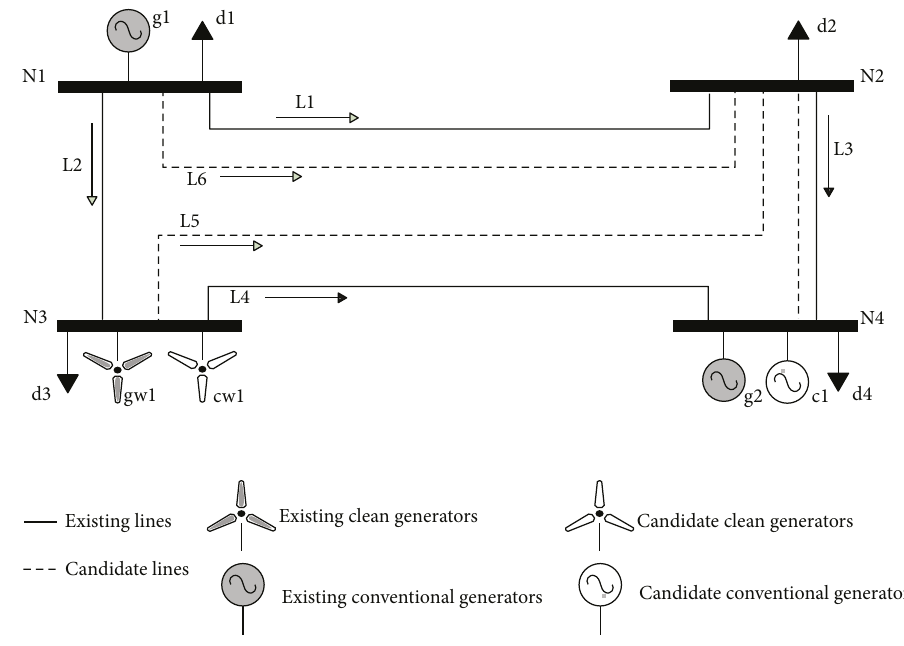
Figure 2: Four-buses test power system.